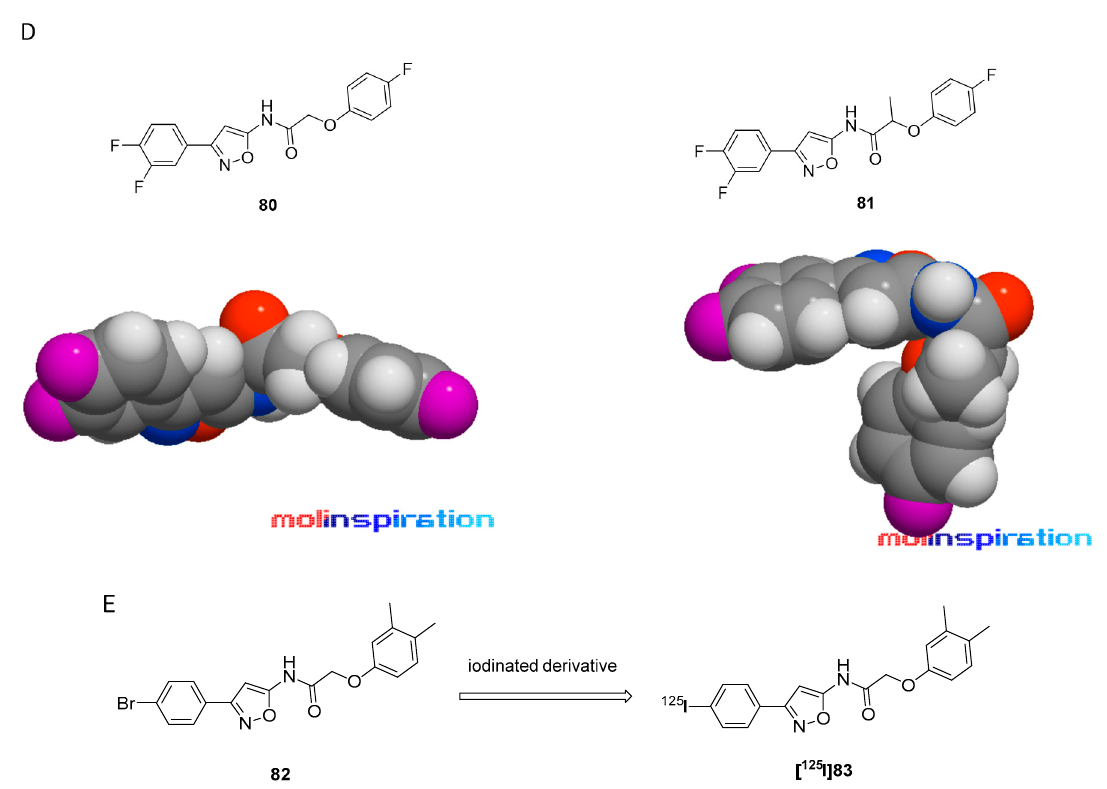
Figure 26. Chemical structures of 2-phenoxy- N -(3-phenylisoxazol-5-yl)acetamide analogues. ( A ) Chemical structure of compounds 65 , [ 3 H]Tg-190b and [ 3 H]BF2846 . ( B ) Chemical structure of compounds 66 , 67 and general structure of most potent α -syn binders. Table represents IC 50 values screened for BS2 and BS9 using [ 3 H]Tg-190b and [ 3 H]BF2846 [139]. * clogP values were calculated by BioByte. ** clogD 7.4 values calculated by ACD/Percepta. ( C ) Chemical structures of compounds 68 – 70 , 77 – 79 ( D ) Models of likely 3D structures of compounds 80 and 81 (visualized by Molinspiration Galaxys 3D Structure Generator v2018.01 beta). Methyl substituent of compound 81 generates non-planar structure in comparison with compound 80 . ( E ) Chemical structure of compound 82 and [ 125 I]83 .